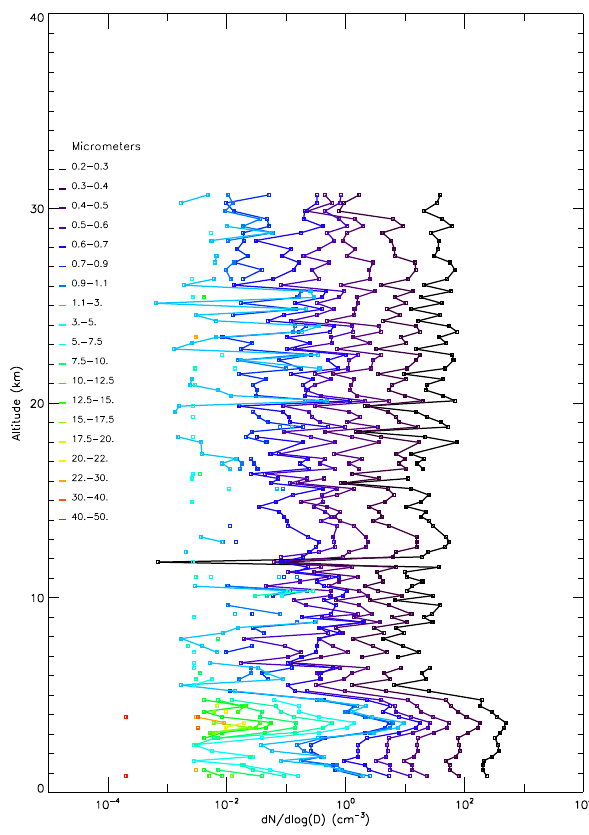
Figure 25. Particle concentrations as a function of size and altitude in the troposphere and lower stratosphere from the LOAC flight un- der meteorological balloon BLD9 launched from Minorca at the end of a dust event on 19 June 2013, 10:12UT (Table 4; see the daytime- averaged aerosol optical depth over the sea in Fig.